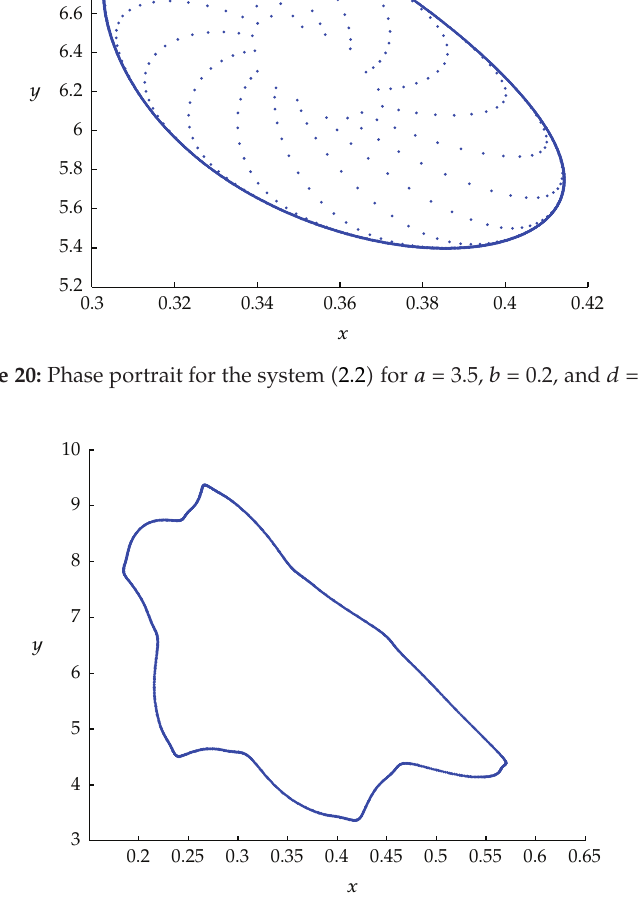
Figure 21: The breakdown of the closed invariant curve of the system (cid:3) 2.2 (cid:4) for a (cid:8) 3 . 5, b (cid:8) 0 . 2, and d (cid:8) 3 .